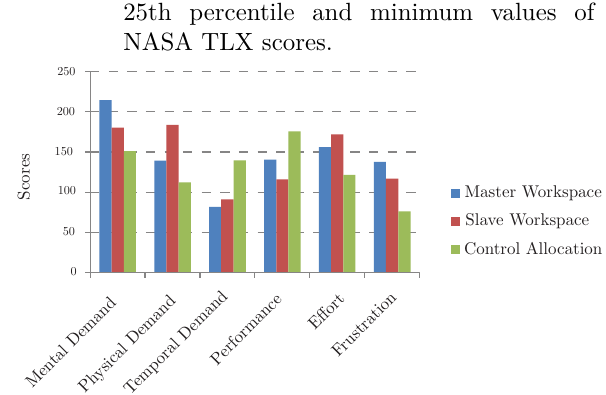
Figure 11: Six different categories evaluated in measur- ing workload